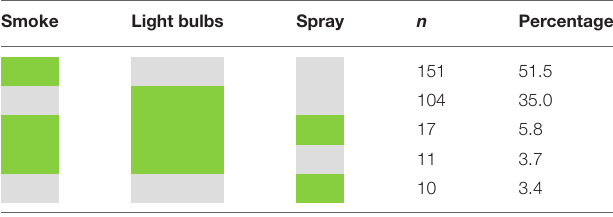
TABLE 3 | Primary patterns of method using for insect control in lumpy skin disease affected farms. Smoke Light bulbs Spray